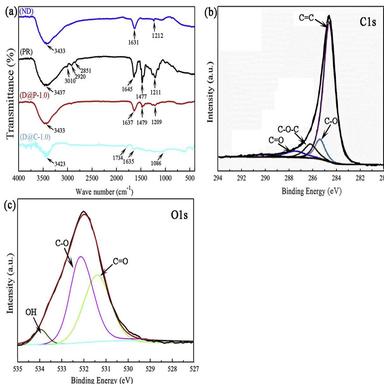
(a) FT-IR spectra of the pristine ND, PR, core/shell structured D@P-1.0 and D@C-1.0, (b, c) XPS high resolution spectra of C1 s and O1 s obtained for the core/ shell structured D@C-1.0.